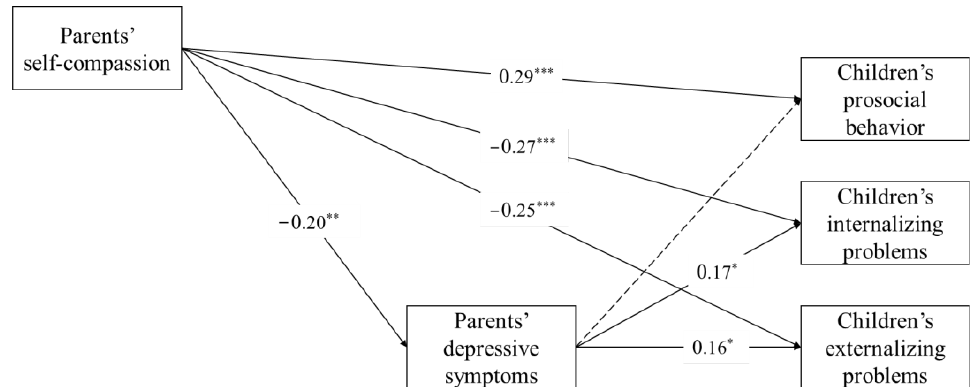
Figure 1. Final model of depressive symptoms as a mediator between parents’ self-compassion and child adjustment. χ 2 (2) = 1.33, p > 0.05, CFI = 1.00, TLI = 1.06, RMSEA = 0.00, SRMR = 0.01. Covariates including monthly family income and child and parent gender were included as control variables but are not depicted in the figure for clarity. Non-significant paths are shown in dashed arrows. * p < 0.05, ** p < 0.01, *** p < 0.001.